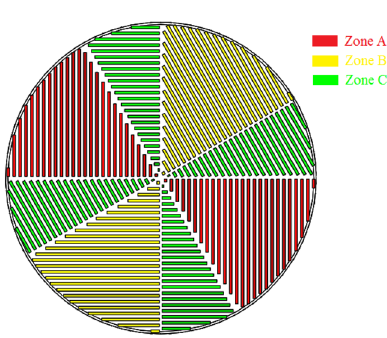
Figure 2. Diagram of isolation